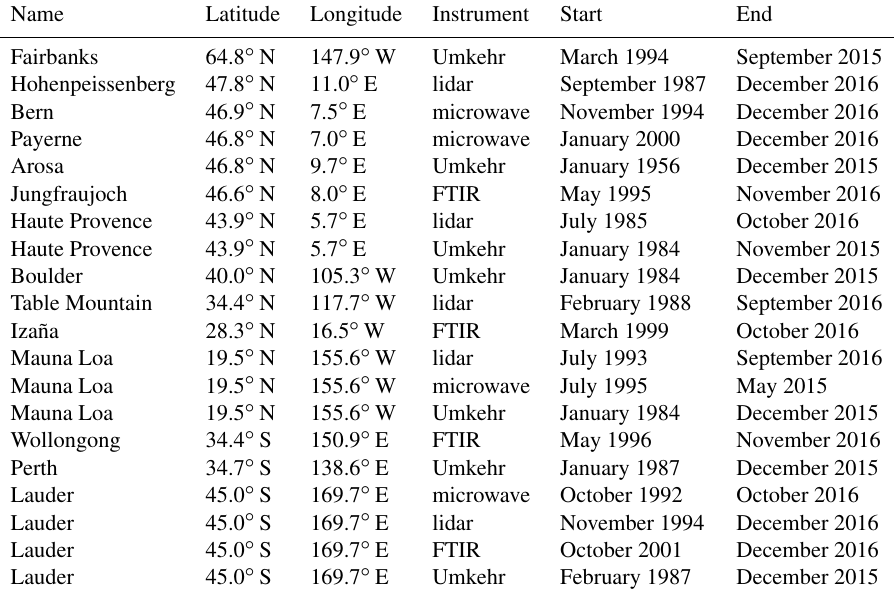
Table 2. Stations and instruments used in the present study. Lidar, microwave, and FTIR data are from the Network for the Detection of Atmospheric Composition Change (NDACC) and are originally available at http://www.ndacc.org. Umkehr data were provided by I.